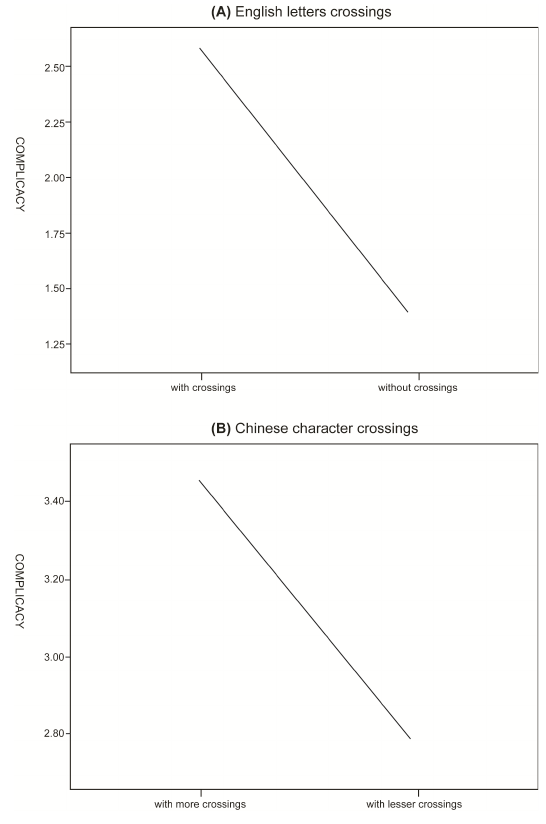
Figure 8. Complicacy of English letters and Chinese characters with various numbers of